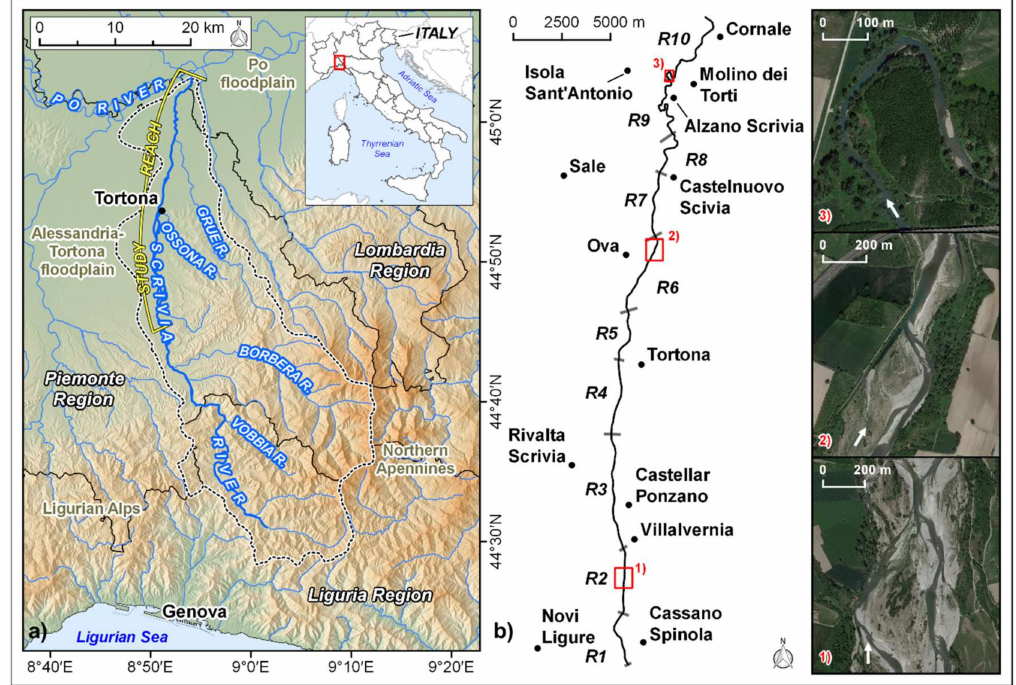
Figure 1. ( a ) Location of the study reach; ( b ) Delimitation of reaches characterized by homogeneous geomorphological features; the red frames highlight sites that are representative of the three major segments outlined along the study reach. See the text for